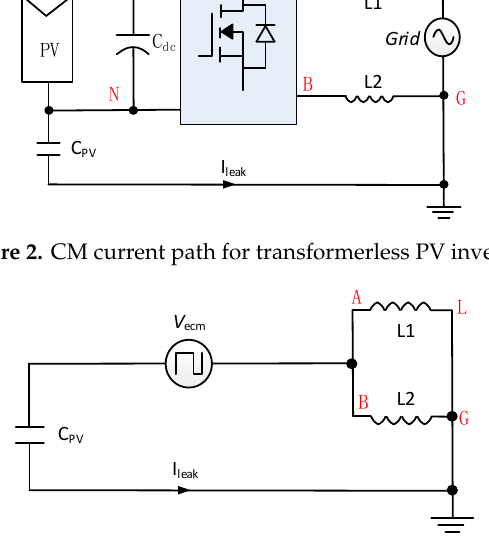
Figure 3. Equivalent circuit for the CM current path.